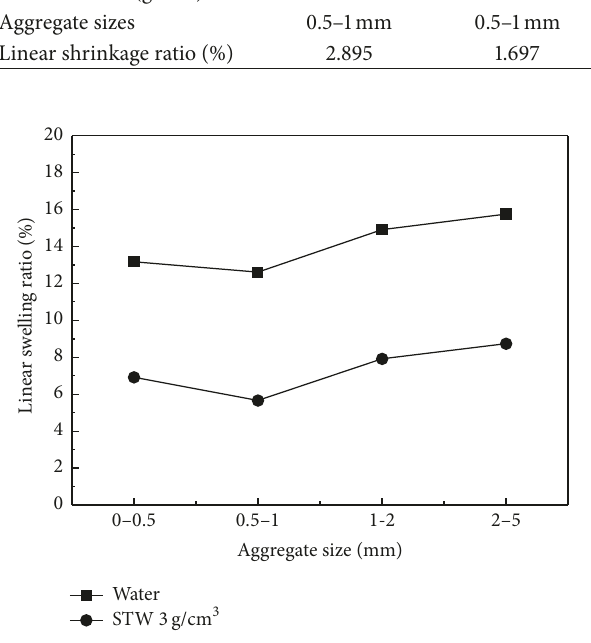
Figure 5: Effect of aggregate size on linear swelling ratio of soils. Figure 6: Effect of aggregate size on linear shrinkage ratio of